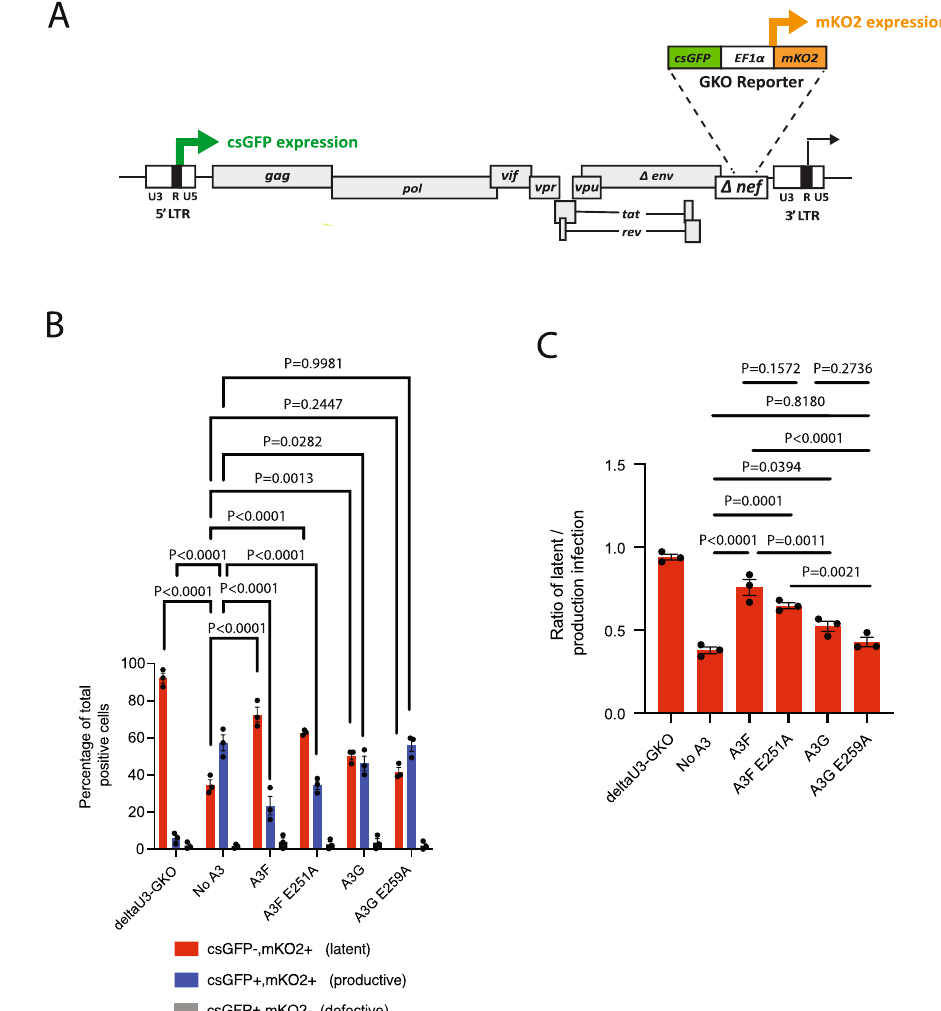
Fig. 8 | A3F andA3G promotelatentinfections in vitro.A Schematicof theHIV-1 GKO reporter vector showing the csGFP gene (green box) under transcriptional controloftheHIV-15 ’ LTRpromoterandthemKO2gene(orangebox)undercontrol of the constitutive EF1alpha promoter. B CEM-SS cells were infected with HIV GKO or HIV GKO- Δ U3LTR inthepresenceorabsenceofA3F,A3F[E251A],A3G,orA3G[E259A]for 48h.Using fl owcytometry,livecellsweregatedonusingZombieNIR TM stainingand the percentage of double-positive (csGFP+, mKO2+) (blue bars) and single-positive